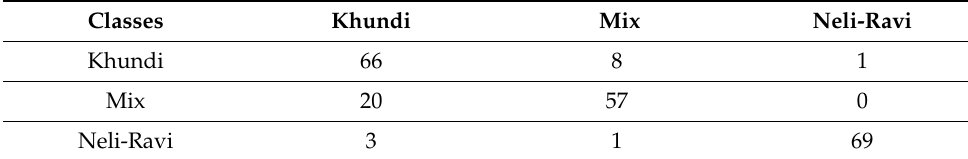
Table 6. Confusion matrix obtained using Coarse-KNN.